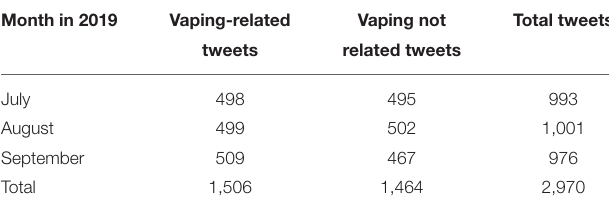
TABLE 2 | Monthly distribution of tweets in the annotated